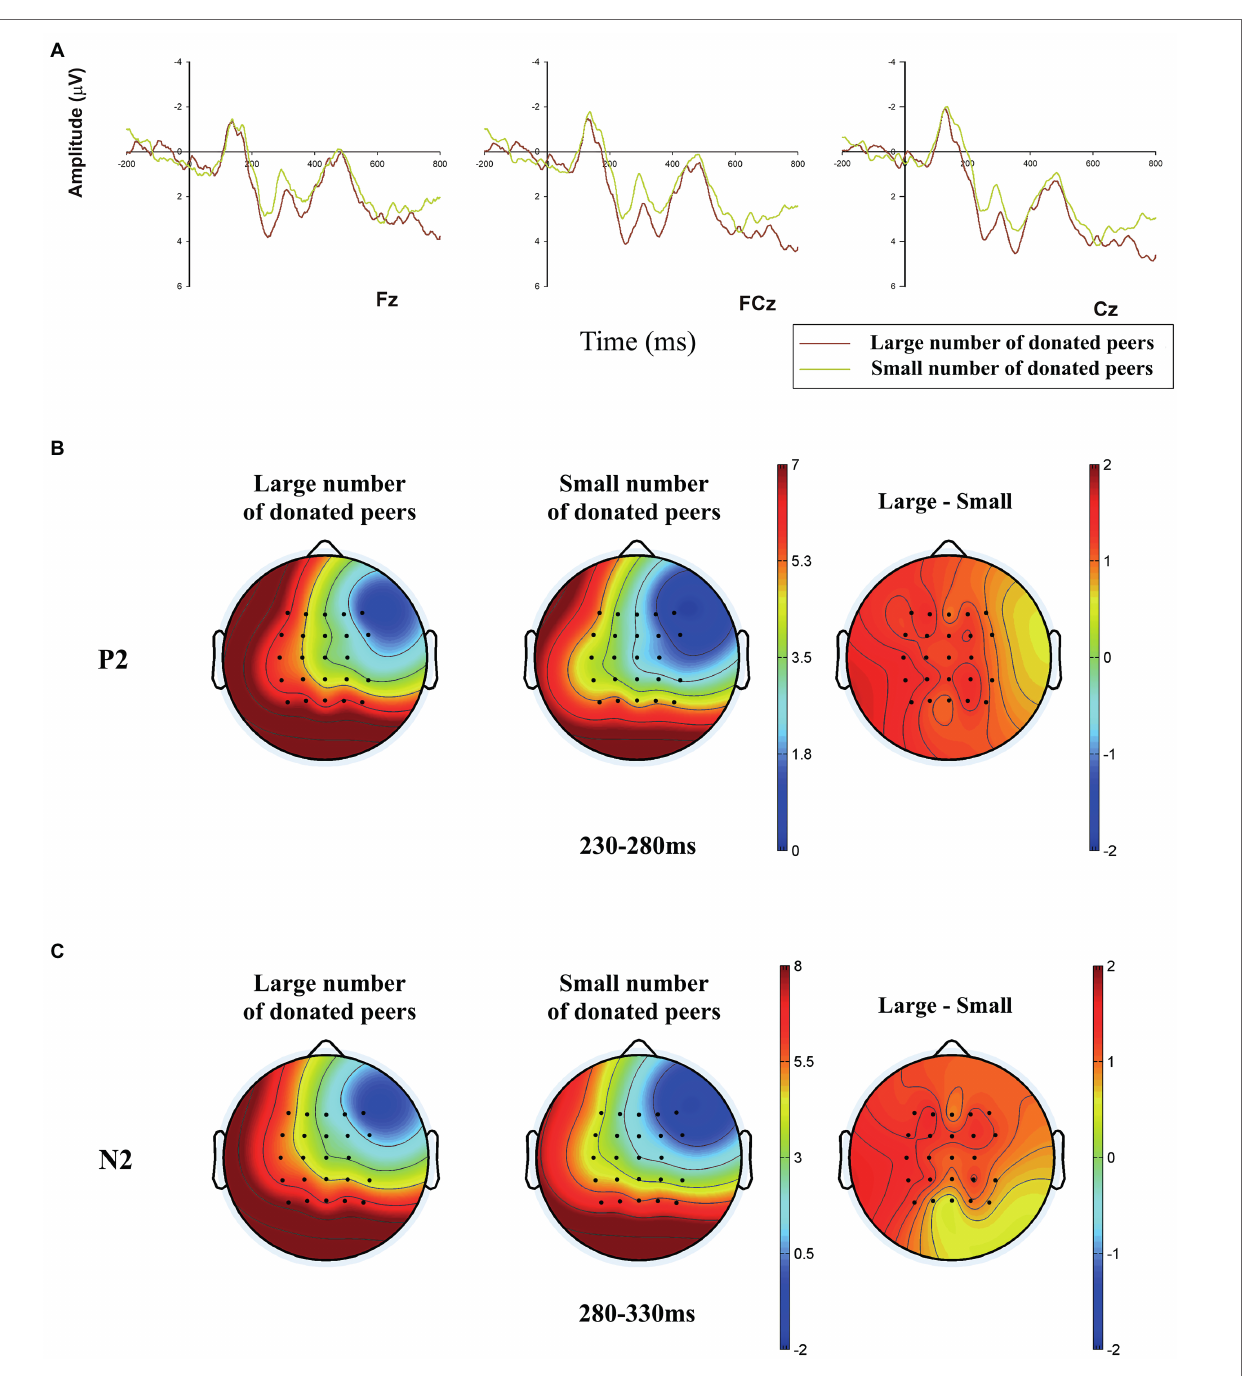
FIGURE 4 | Grand-averaged event-related potential (ERP) waveforms of P2 and N2 in the three electrodes of frontal-to-central brain region, and related brain topographies. (A) The demonstration of P2 and N2 amplitudes in the two conditions (large vs. small number of donated peers) in representative electrodes (Fz, FCz, and Cz); (B) The P2 brain topographies of the two conditions in the time window of 230–280 ms; (C) The N2 brain topographies of the two conditions in the time window of 280–330